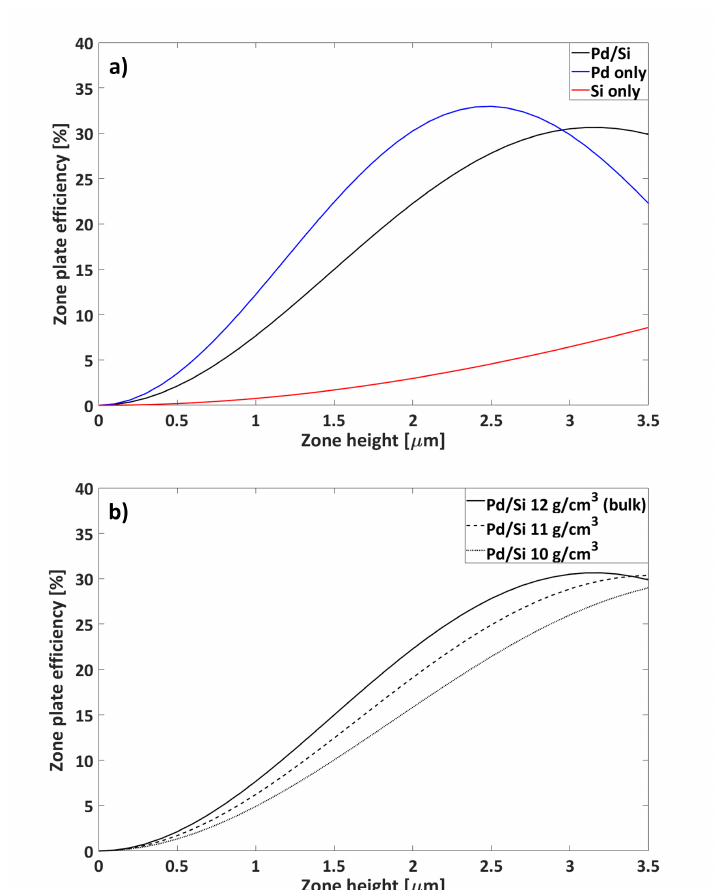
Figure 4. Zone plate efficiency at 9 keV as a function of zone height for ( a ) Pd/Si, Pd only, and Si only zone plates (bulk densities) and ( b ) Pd/Si zone plates with different Pd densities and bulk Si density. Calculations were done in MATLAB with